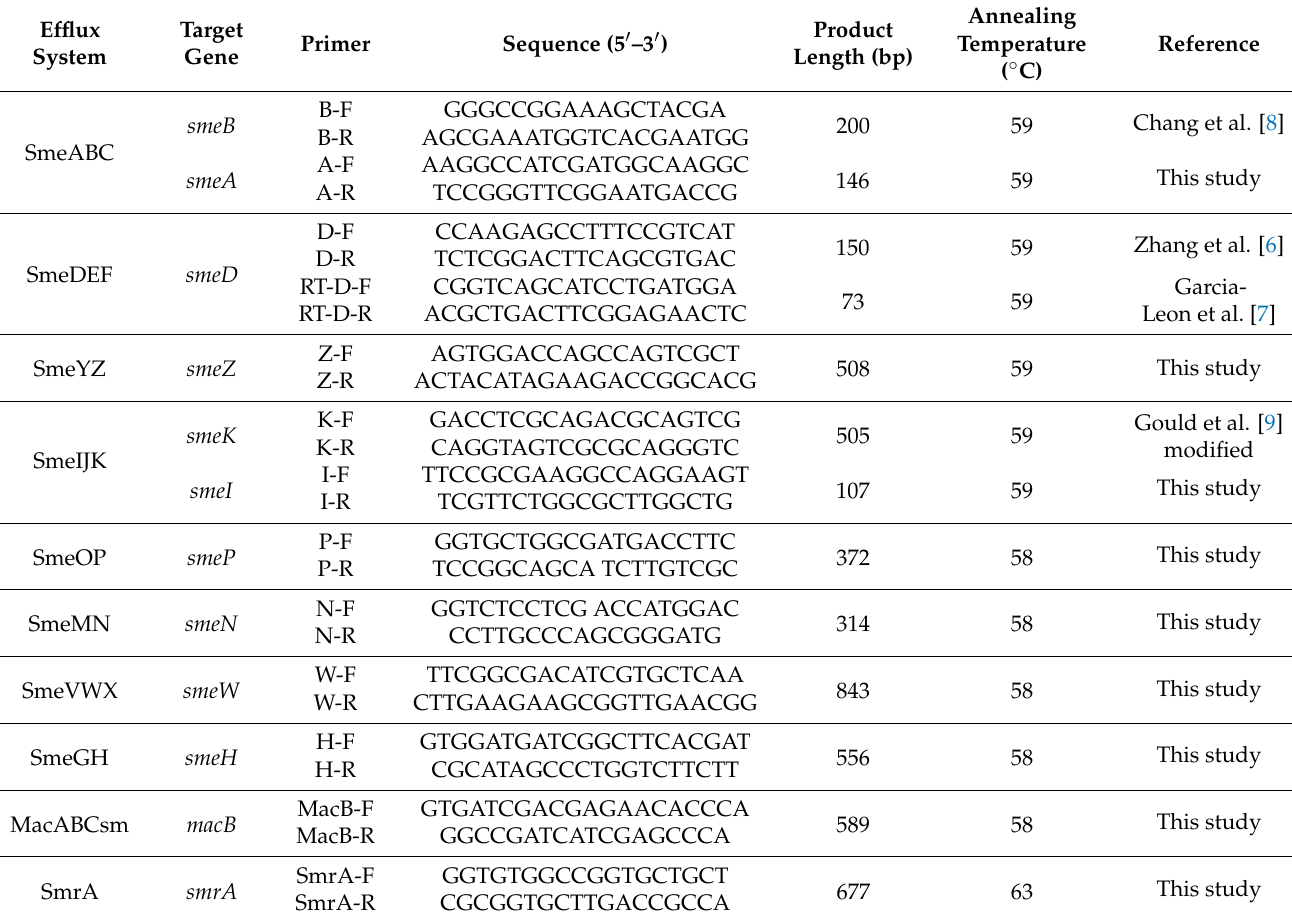
Table 1. Primers for the amplification of genes encoding MDR efflux